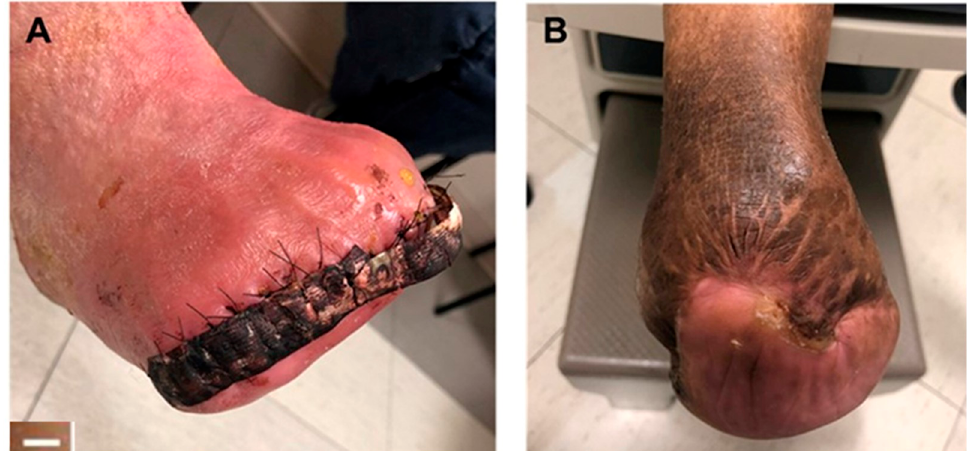
Figure 6. ( A ) A representative wound after TMA surgery. A strip of the synthetic hybrid-scale fiber matrix was applied over the closed wound. ( B ) A representative image of a healed TMA wound after treatment with the synthetic matrix . Scale bar represents 1 cm.